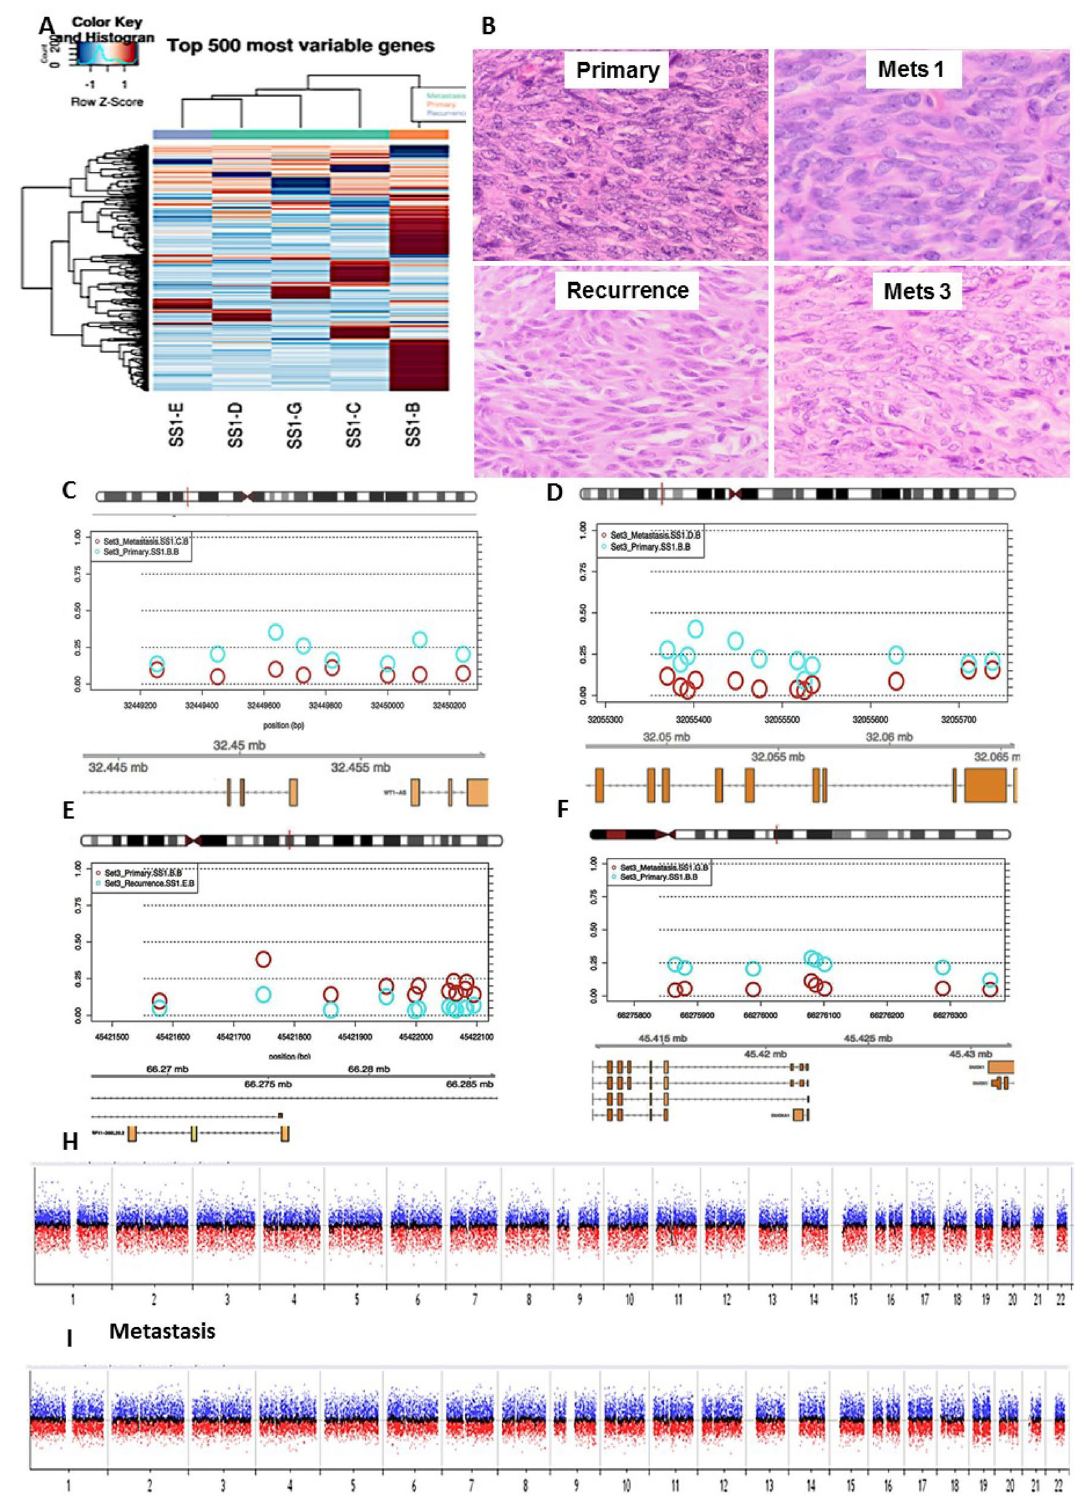
Figure 5. Heatmap of the 500 most differentially methylated probes ( A ) between primary synovial sarcoma (SS; SS1-B), recurrence (SS1-E), Mets1 (SS1-C), Mets2 (SS1-D) & Mets3 (SS1-G; M-values). Illumina Infinium MethylationEPIC BeadChip and R statistical environment (v.3.5.1). Histological images of 4 of 5 of the samples used for methylation array ( B ). B-values, probe distribution and genomic annotation of differentially methylated regions (DMRs: C – F ). Primary versus Mets1 containing WT1-AS in Chr 11 (991 bp region: C ). Primary versus Mets2 contatining TNXB & SP2D6 in Chr 6 (369 bp regionL: D ); Primary versus Rec containing DUOX11 & DUOXA1 in Chr 15 (518 bp region: E ); Primary versus Mets3 contatining RP11-366l20.2 in Chr 12 (499 bp region: F ). Primary beta values are plotted in blue and Metasatic/Recurrence beta values are plotted in red. Array comparative genomic hybridisation plots of primary SS ( G ) and Mets2 ( H ), demonstrating no significant chromosomal gains, losses or amplifications in any of these samples. Genome View, numbers correspond to chromosomes 1–22, middle black line indicates the average log ratio for the probes (SurePrint G3 Human CGH Microarrays 8 × 60 K and CytoGenomics Software (Agilent,